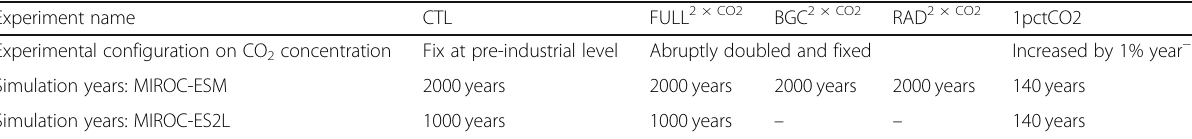
Table 1 Models, experimental configurations, and time periods of simulation used in this